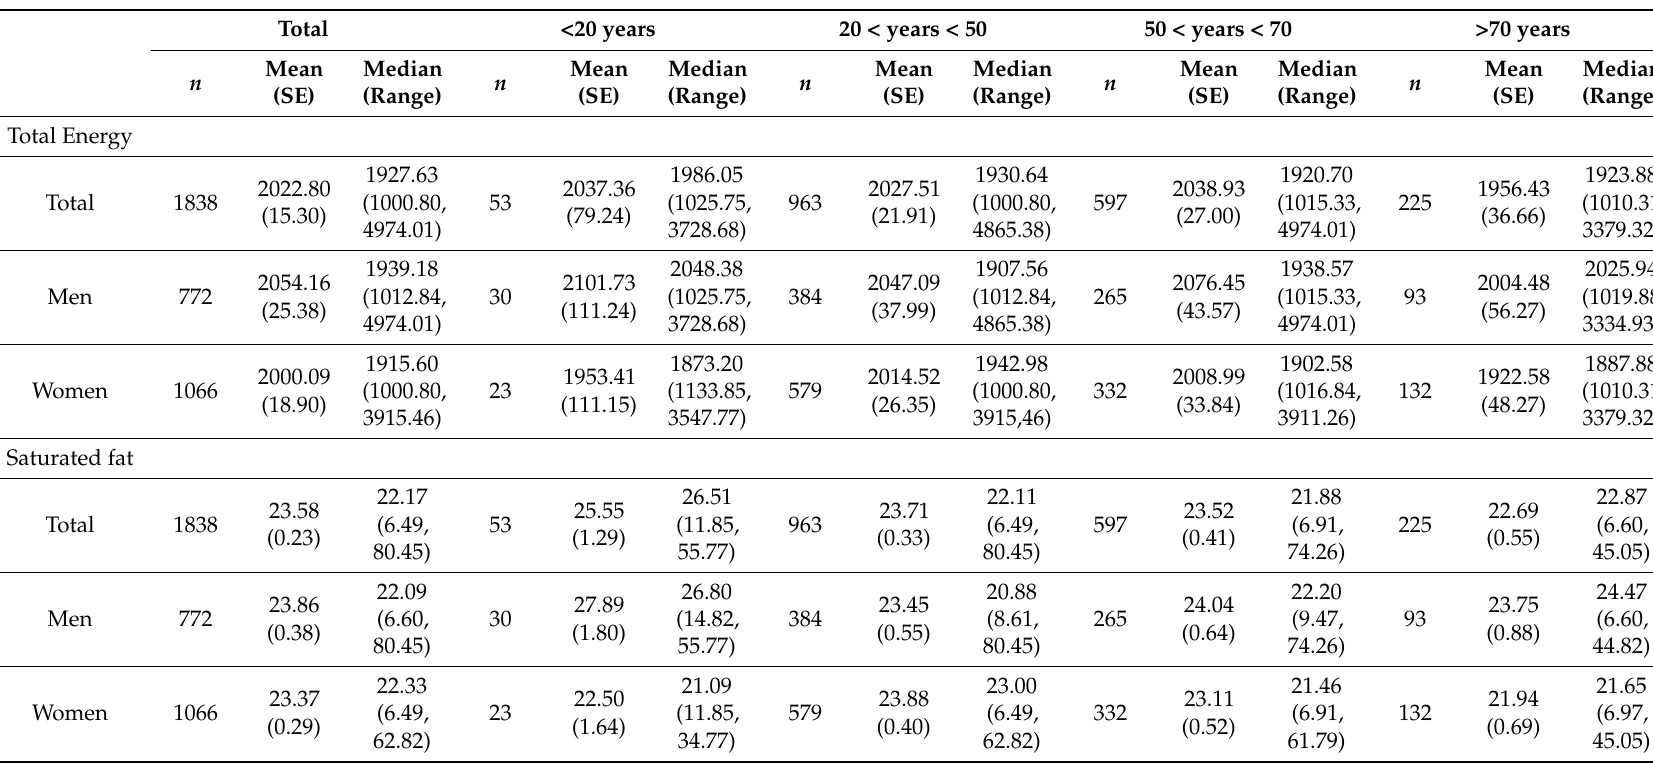
Table 1. Total, sex, and age group-specific consumption of macronutrients and fiber in the study participants of the Mediterranean healthy eating, ageing, and lifestyle (MEAL) study ( n = 1838). * denotes p <